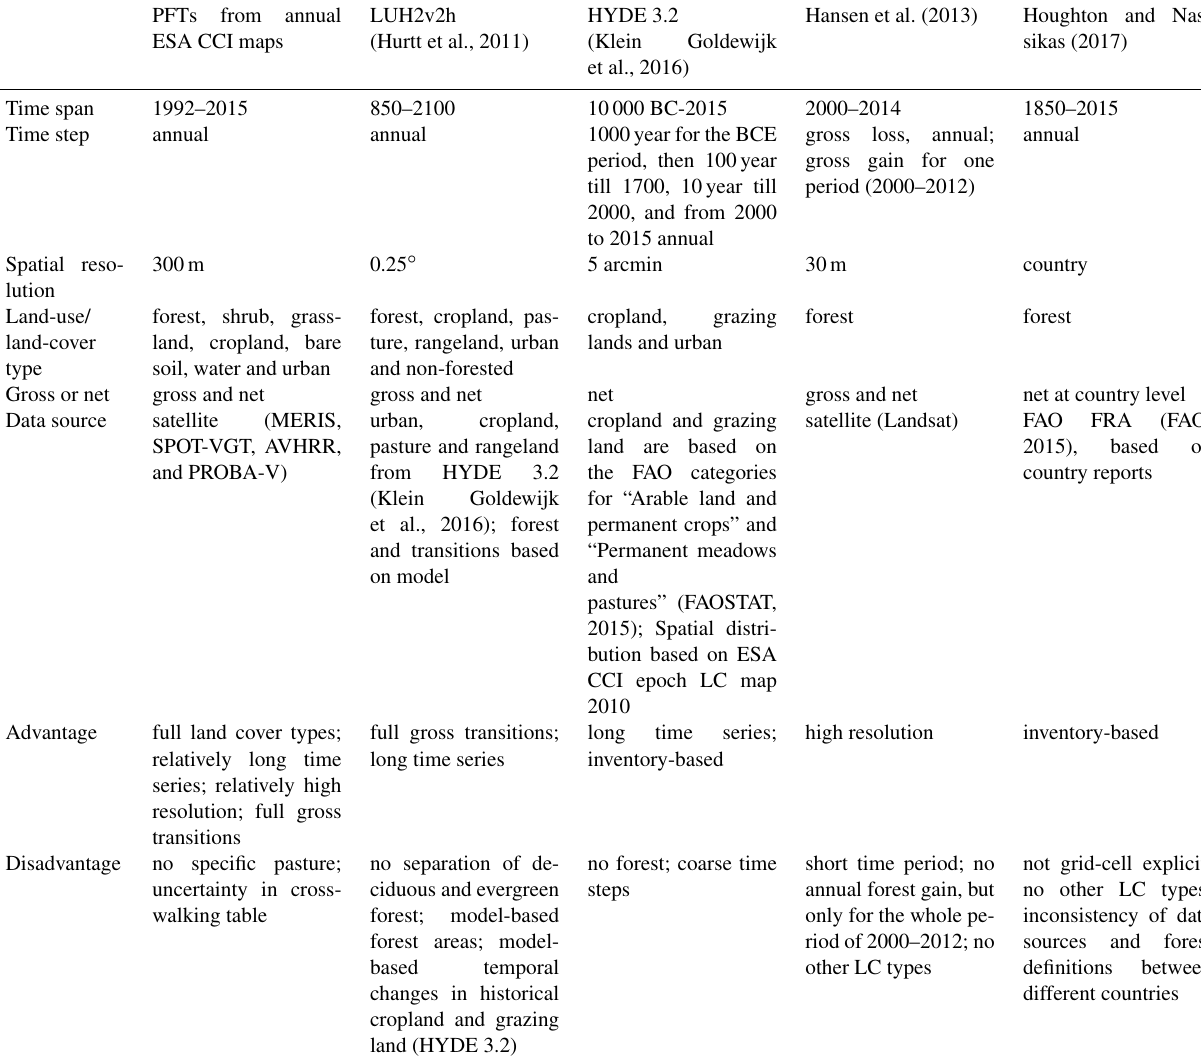
Table 1. Description and comparison of different land-use/land-cover datasets used in this study. The term of “dataset” in this study can also involve some model output (e.g. forest area from Land Use Harmonization dataset,